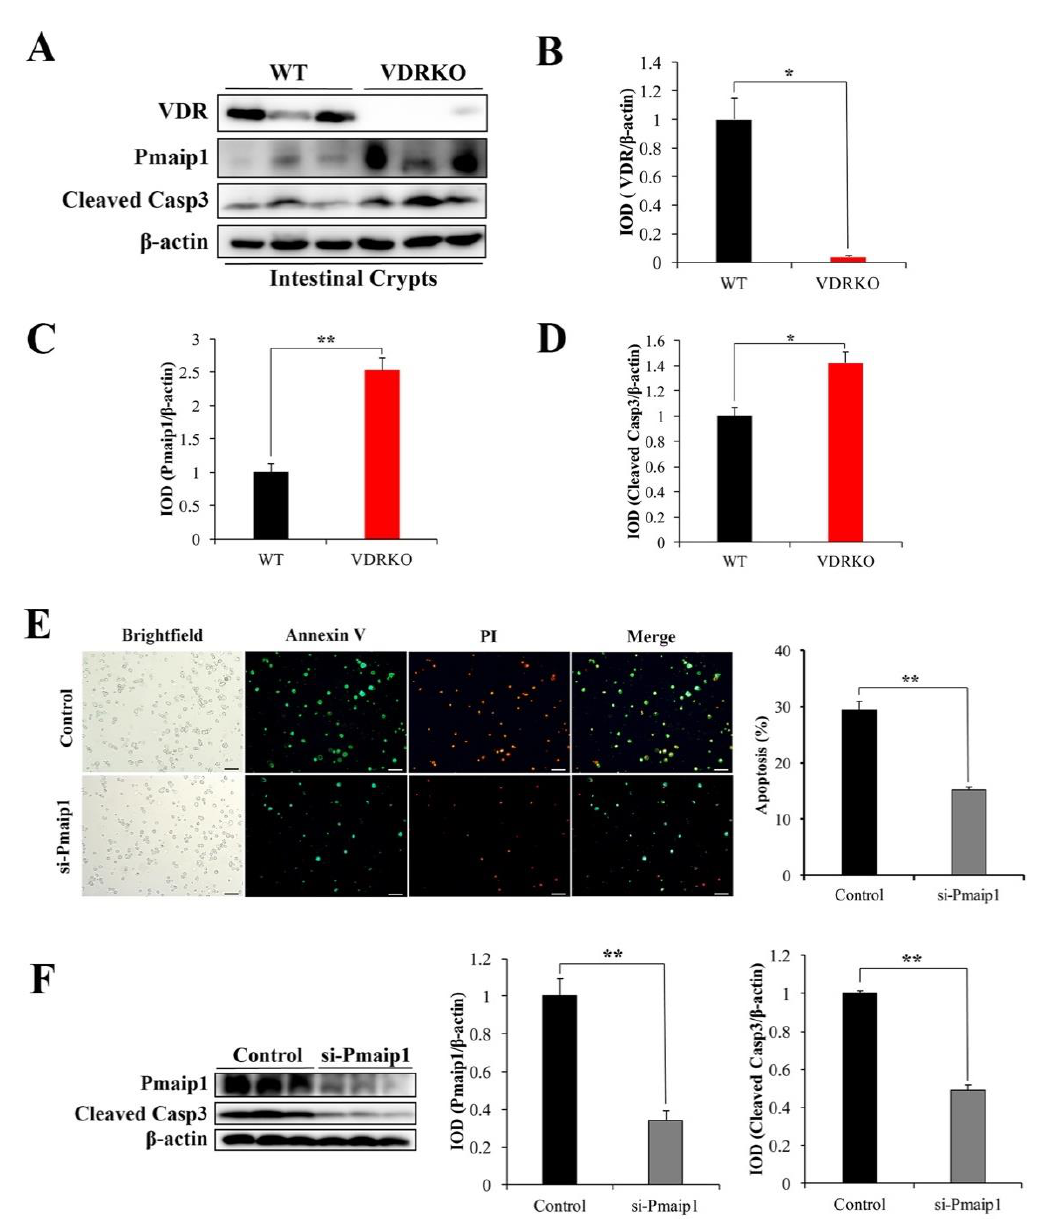
Figure 6. VDR suppresses IR-induced crypt stem/progenitor cell apoptosis via the Pmaip1-mediated pathway. ( A ) VDR, Pmaip1 and Cleaved Casp3 were analyzed in crypt stem/progenitor cells from WT and VDRKO mice at 5 h after IR by WB. ( B – D ) Quantitative analysis of WB of VDR, Pmaip1 and Cleaved Casp3 expression, respectively. ( E )